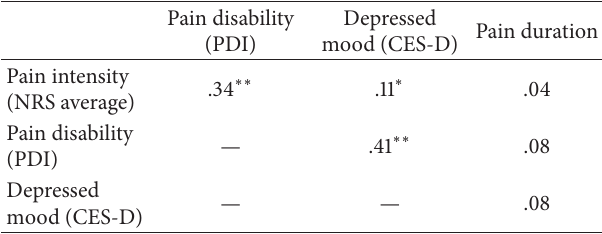
Table 2: Bivariate correlations (Pearson correlation